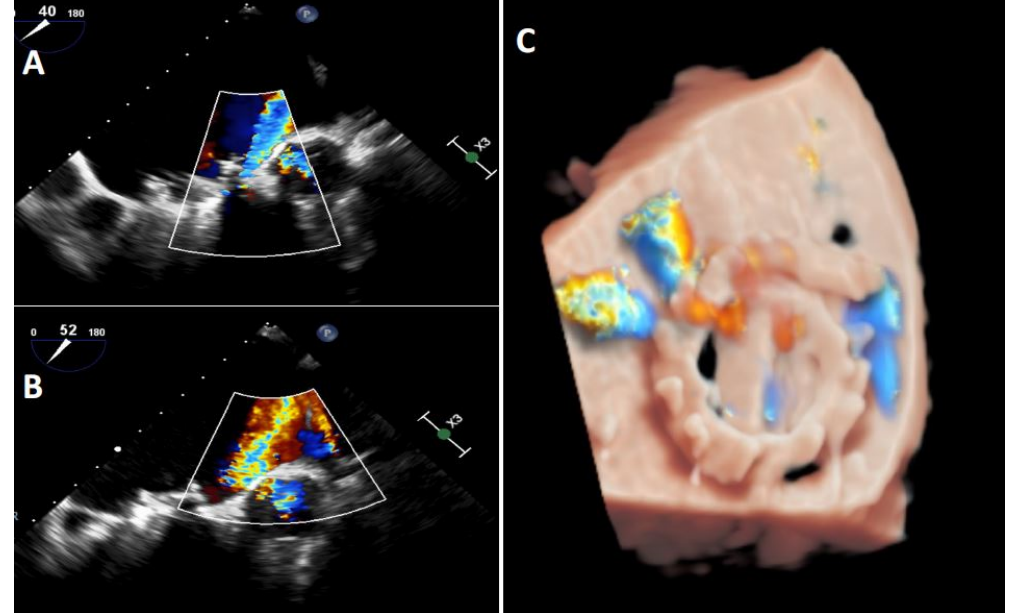
Figure 3. Mitral TEE. ( A , B ): regurgitation jet more severe that we could see at TTE on figure ( A ); ( C ): Truevue with colour Doppler.